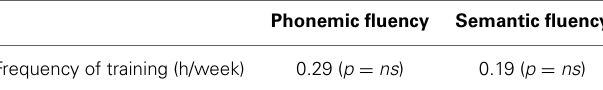
Table 6 | Spearman’s rank correlation coefficients between older musicians’ frequency of training and their phonemic and semantic fluency